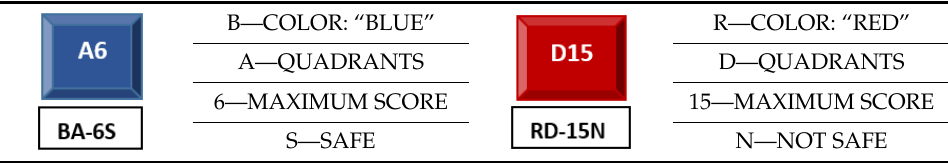
Table 2. Alphanumeric Concept of Quadrant Risk Classification and Management Action